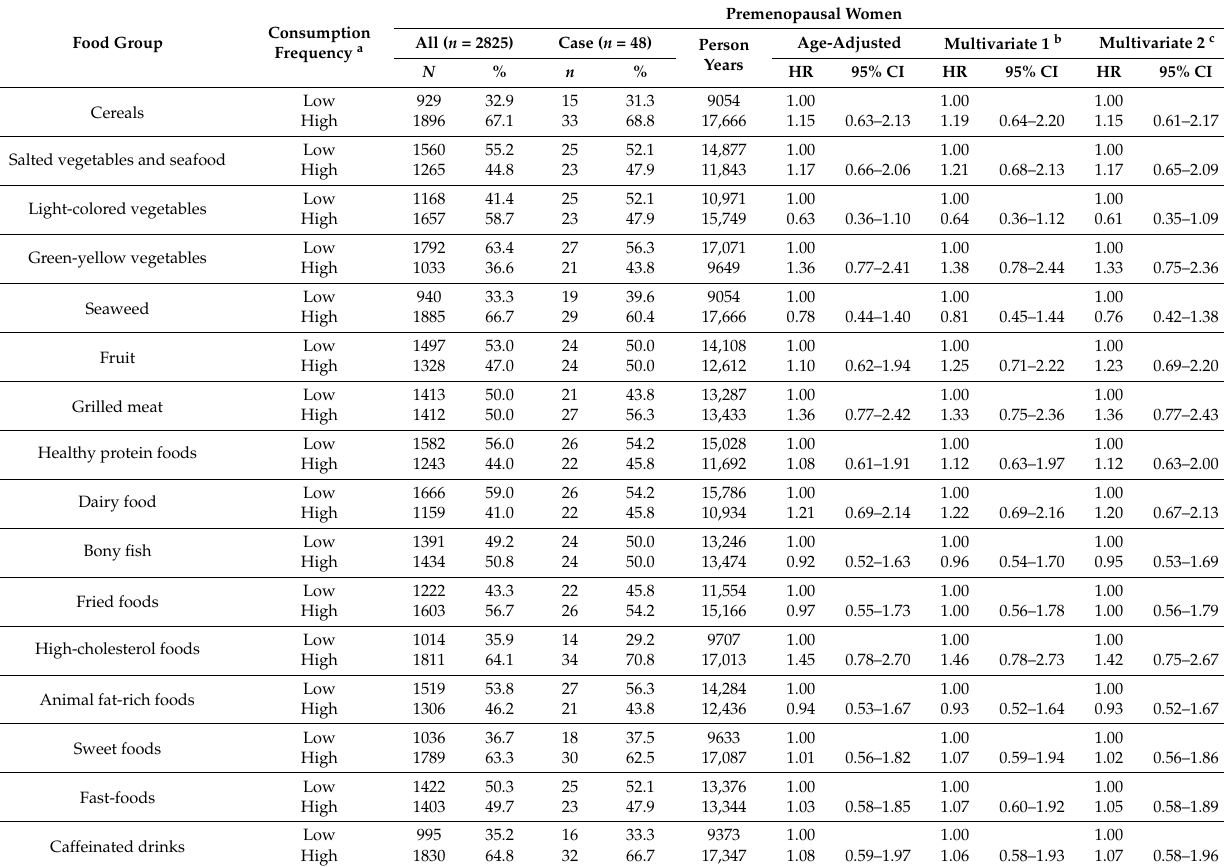
Table 3. Sixteen food groups and their associations with the risk of breast cancer in premenopausal